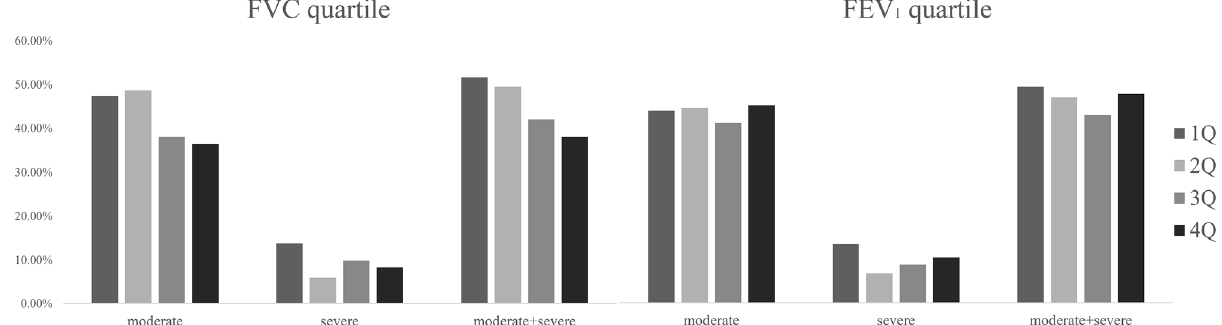
Figure 3. The percentage of patients who experienced COPD exacerbation in a year by ΔFVC quartile and ΔFEV 1 quartile. FVC quartile showed the decreasing tendency of moderate-to-severe exacerbation without clinical significance. In the comparison by FEV 1 quartiles, they did not show any significant differences. COPD chronic obstructive pulmonary disease, Δ annual changes of the postbronchodilator values, FEV 1 forced expiratory volume in one second, FVC forced vital capacity, Q quartile.